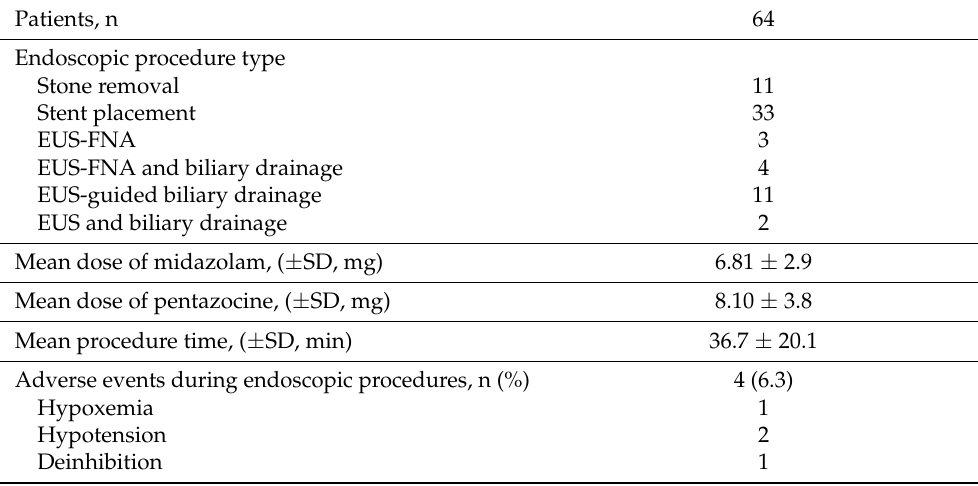
Table 3. Procedure outcomes.